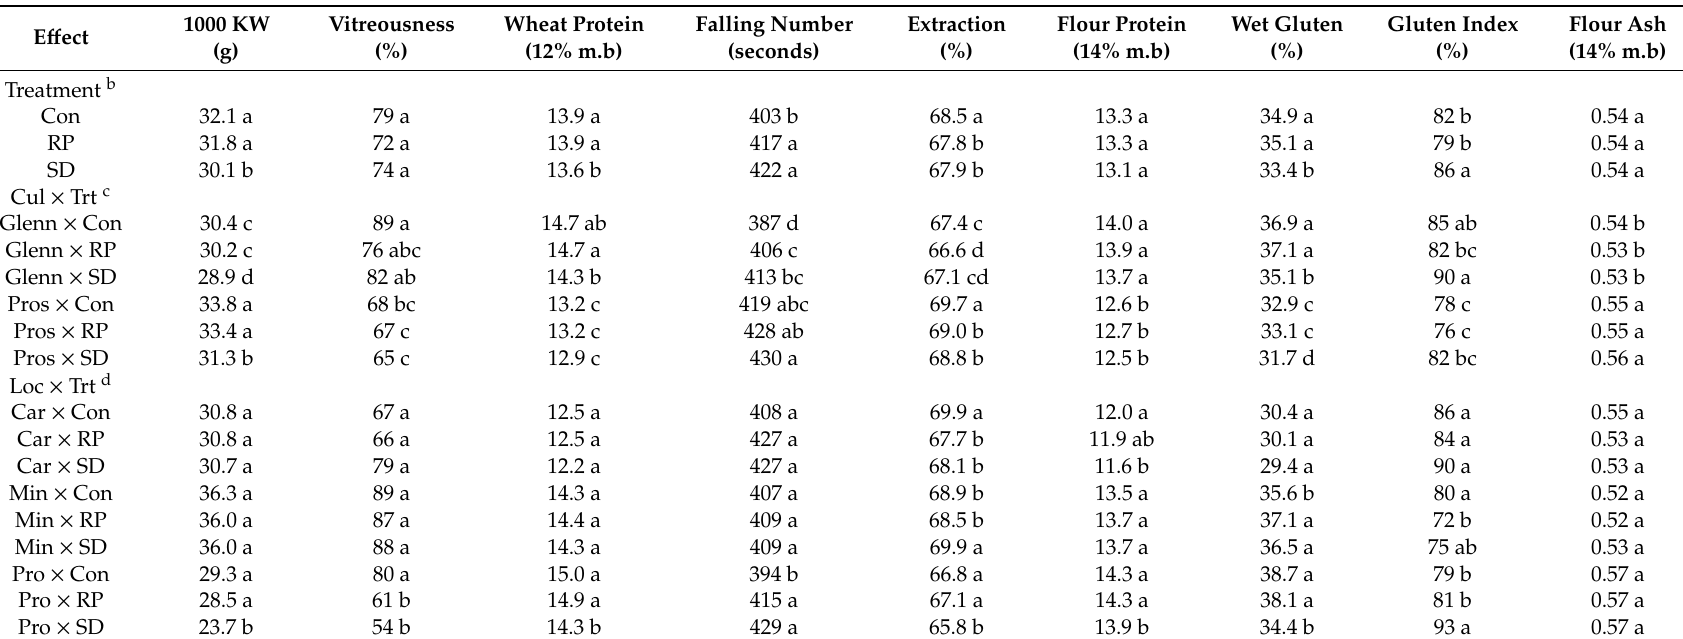
Table 1. Average values for kernel, milling and flour quality characteristics for di ff erent glyphosate treatments